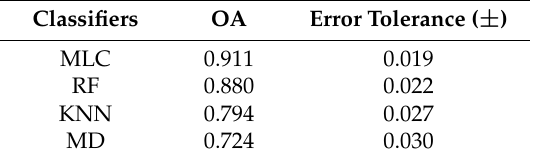
with 4 bands and 10 bands,